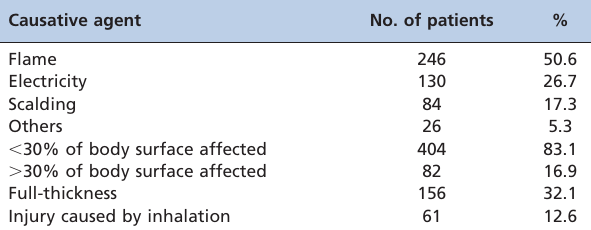
Table 1 - Characteristics of the burn injuries in 486 patients.